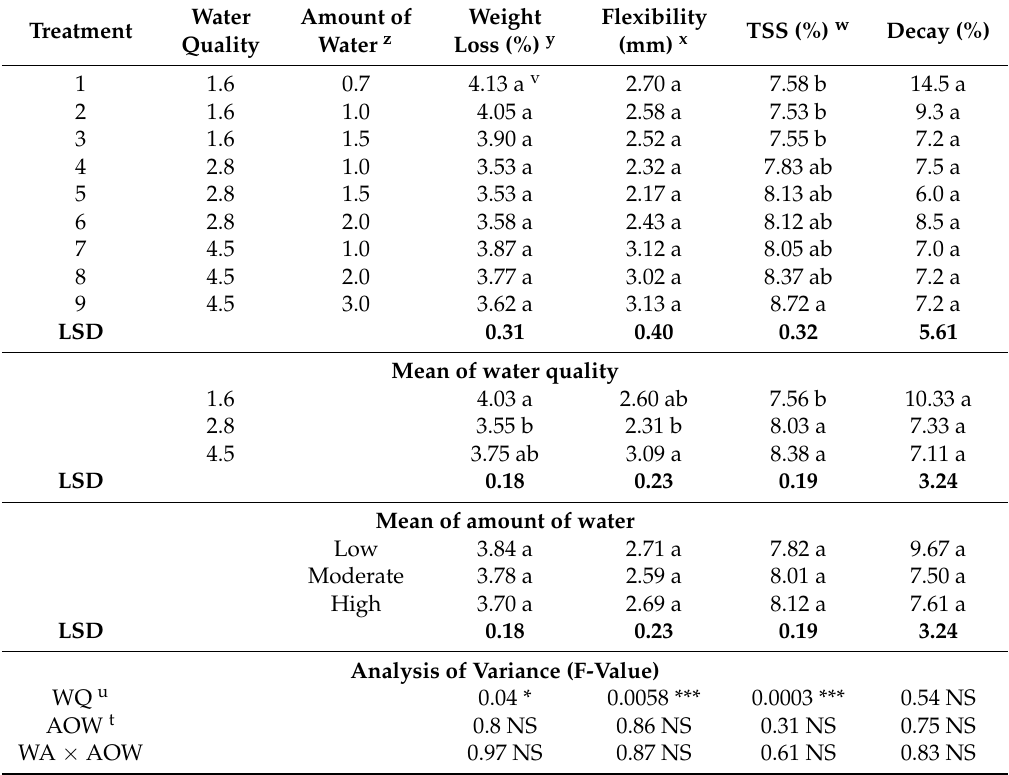
Table 2. The influence of water quality and irrigation water amount on pepper fruit quality after 14 days at 7 ◦ C plus three days at 20 ◦ C. Means of six harvests during two